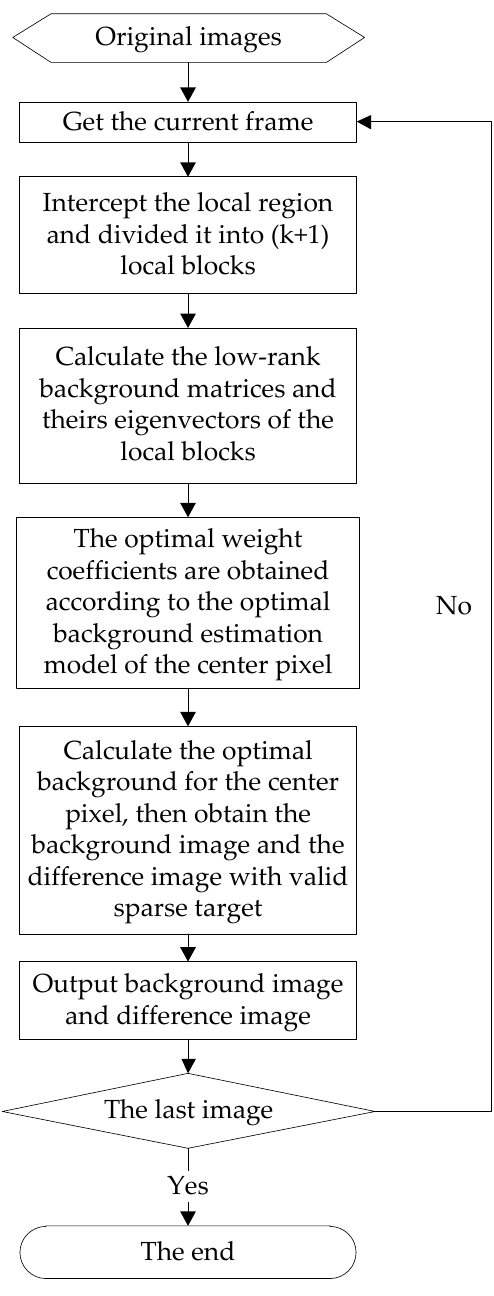
Figure 6. The flow diagram of the SPB methods.